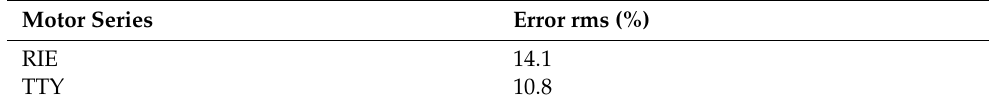
Table 2. Model regression error RMS.